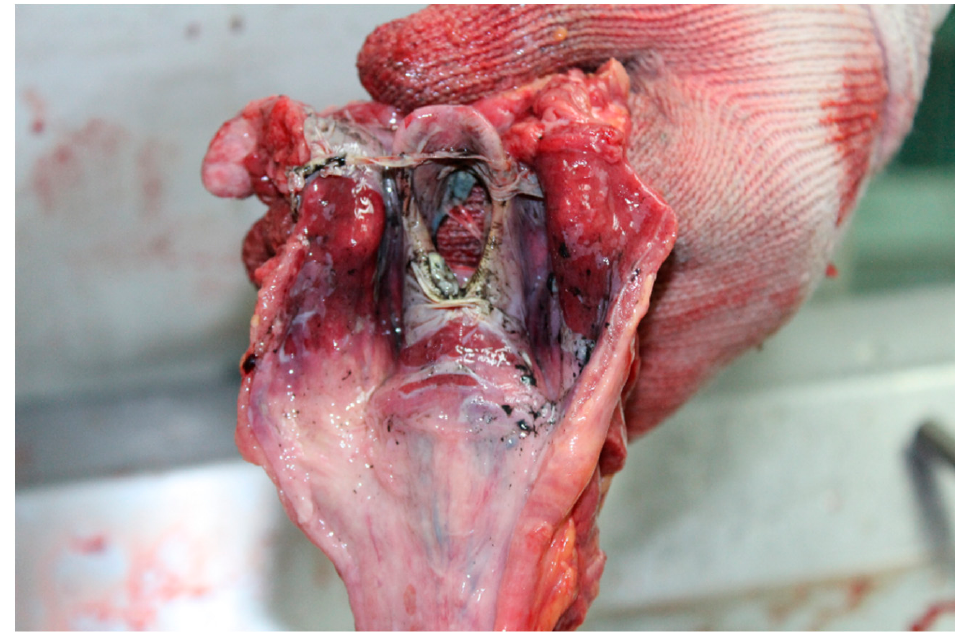
Figure 1. Laryngopharynx after dorsal dissection: The presence of deposited soot. Laryngeal edema and the effect of heat on tissues.